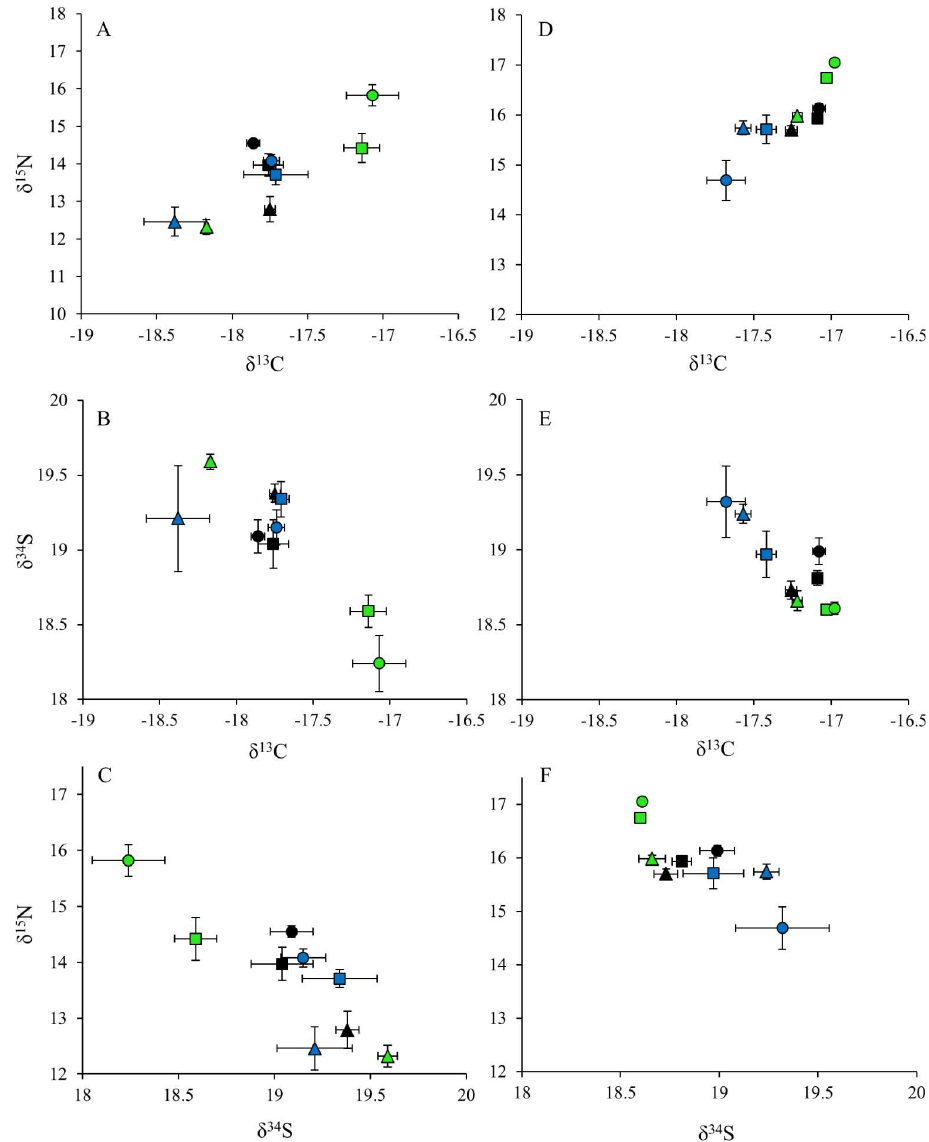
Fig 4. Mean stable isotope bi-plots for gray triggerfish and red snapper by size class and region. Panels A, B, and C (left) represent gray triggerfish, while panels D, E, and F represent red snapper (right). Means for δ 13 C, δ 15 N, and δ 34 S are shown for each species by size class, juveniles (triangles), sub-adults (squares), and adults (circles), and by region, east (green), central (black) and west (blue); error bars represent the standard error. (12.32 ± 0.12 % ) in the east region (p < 0.01, Shaffer’s MCP) (Table 4). Red snapper δ 15 N val- ues increased significantly from juvenile to sub-adult size classes across all regions (p < 0.05, Shaffer’s MCP), with the exception of the west region, where δ 15 N values were similar among size classes (Table 4). Similarly, red snapper δ 15 N values increased between sub-adult and adult size classes in the east region (p < 0.0001, Shaffer’s MCP), but significantly decreased between sub-adult and adult size classes in the west region (p = 0.036, Shaffer’s MCP) (Fig 4C and 4F). Gray triggerfish δ 34 S values were significantly higher in juveniles compared to sub- adult and adult size classes in the east region (p < 0.01, Shaffer’s MCP), while juvenile red